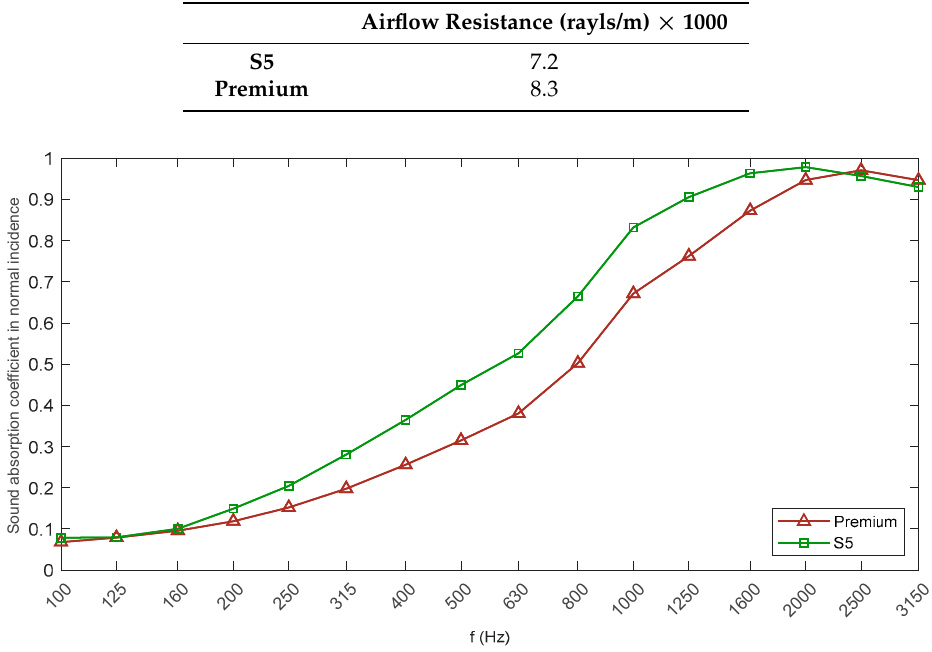
Figure 7. Sound absorption coefficient in normal incidence of Premium and S5 sheep